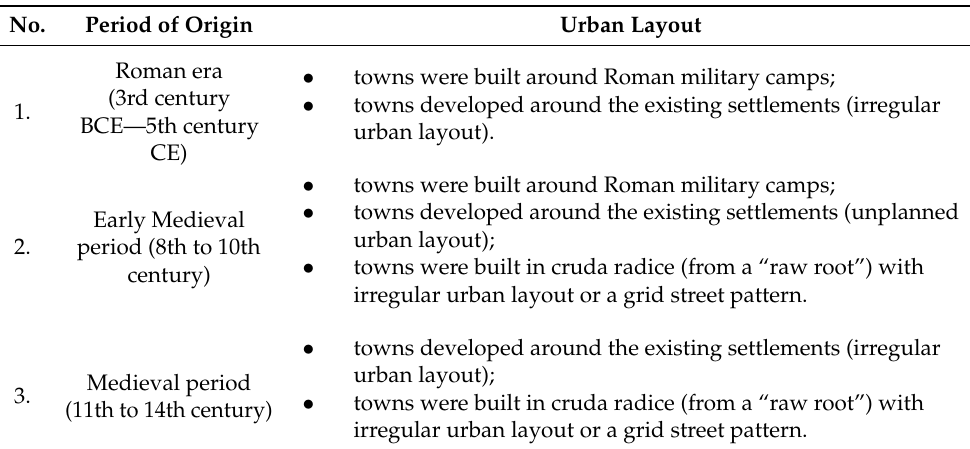
Table 1. The influence of founding date on the urban layout of the analyzed towns.